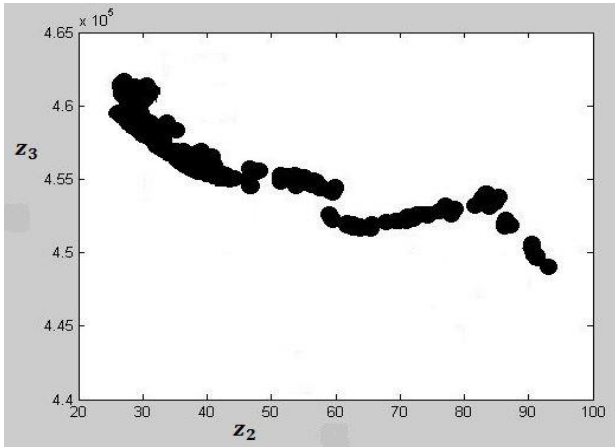
Fig. 9. Pareto frontier for the cost of delivery time.